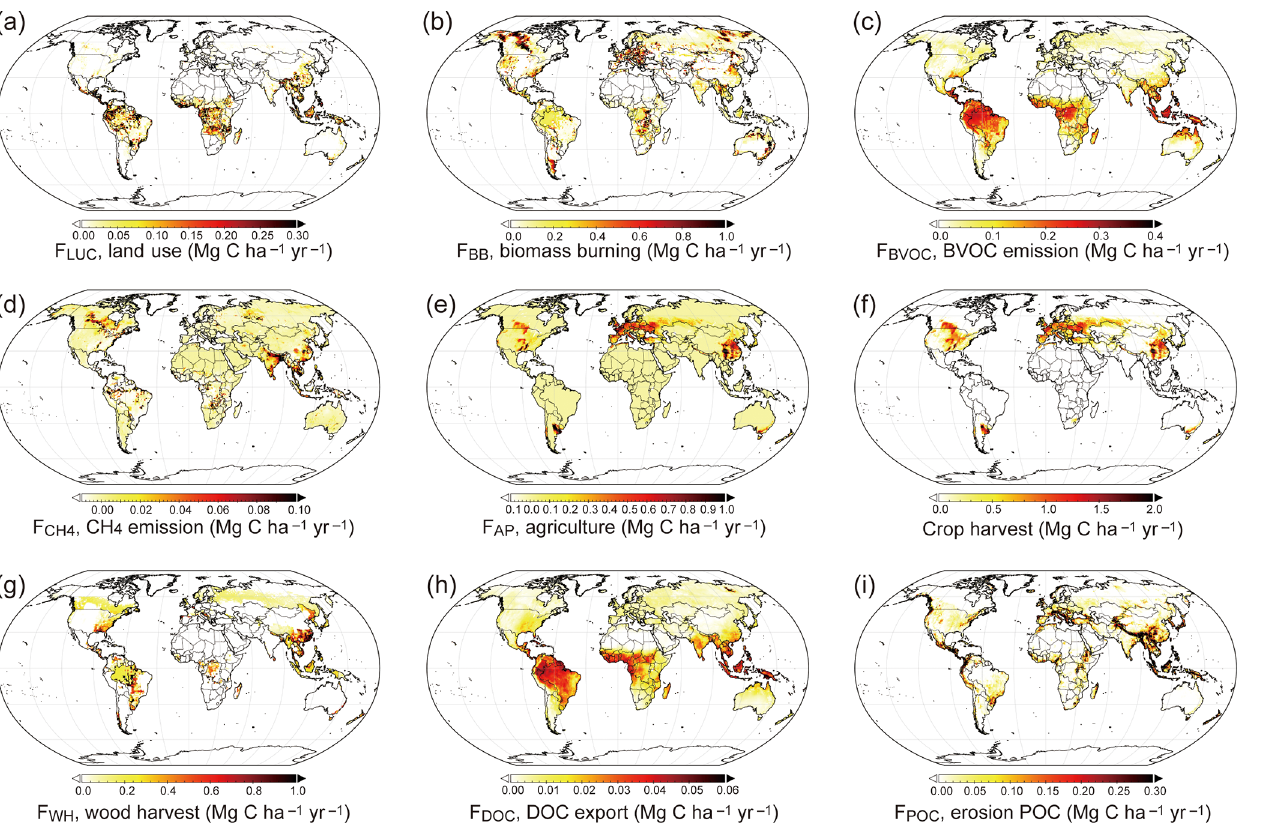
Figure 6. Global distribution of the simulated MCFs (plus crop harvest) in 2000–2009. Results of EX ALL are